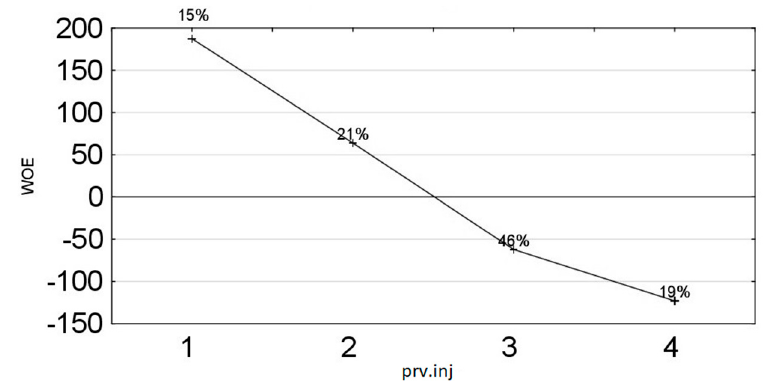
Figure 4. WoE (weight of evidence) graph for the variable previous injuries Figure 3. WoE (weight of evidence ) graph for the variable previous injuries.